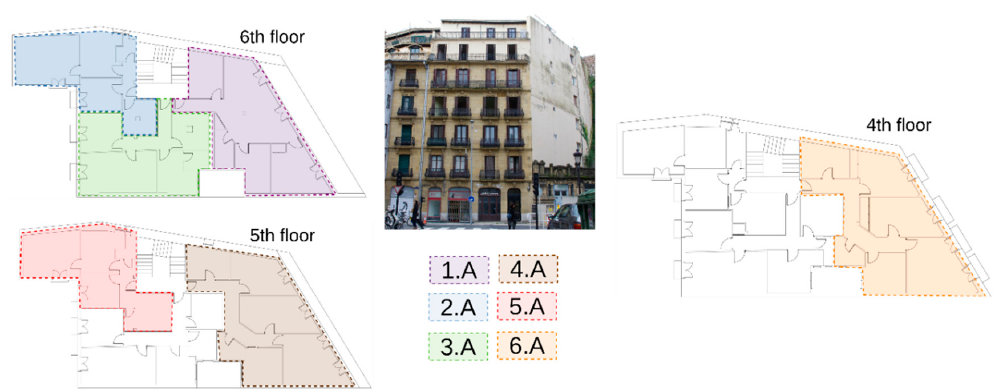
Figure A1. Floor plans of the blower door tests performed in the Easo 22 case study.